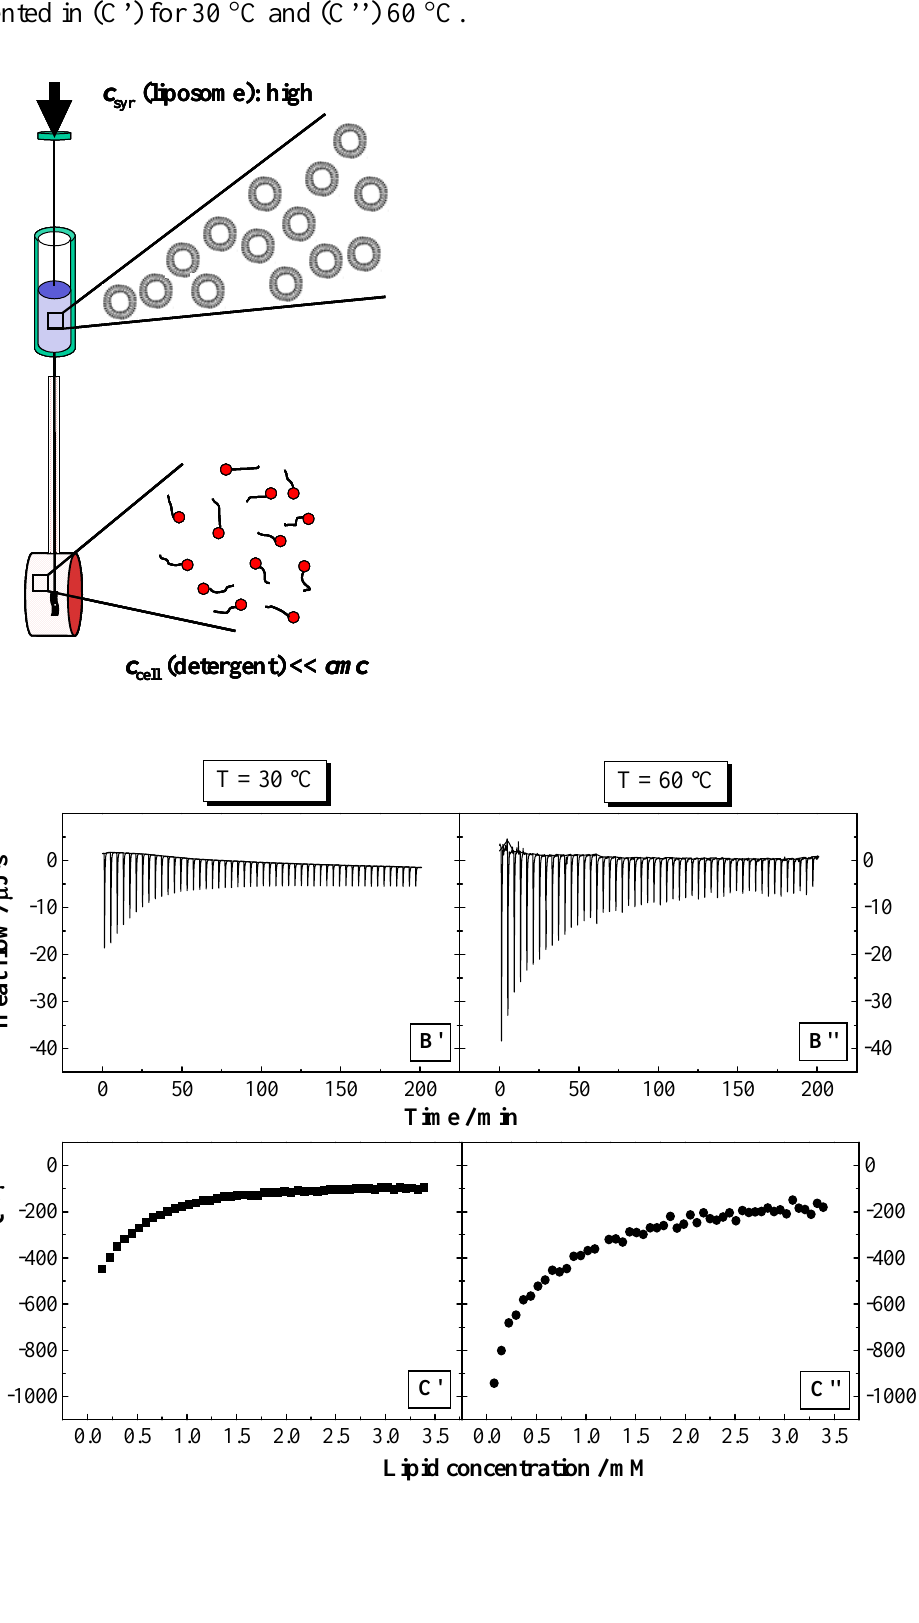
(detergent) << cmc ). (B) cell